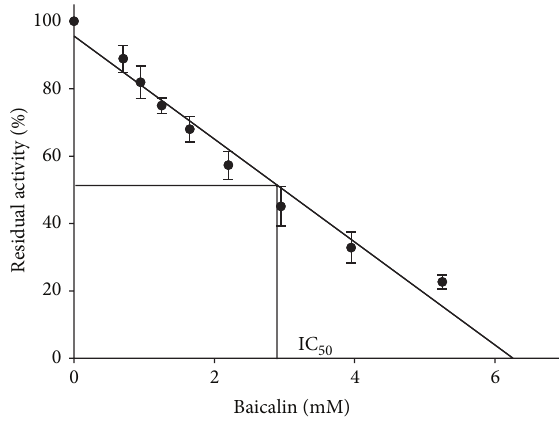
Figure 2: Dependence of residual activity versus concentration of BA. The results are expressed as means ± SD of the data from triplicate